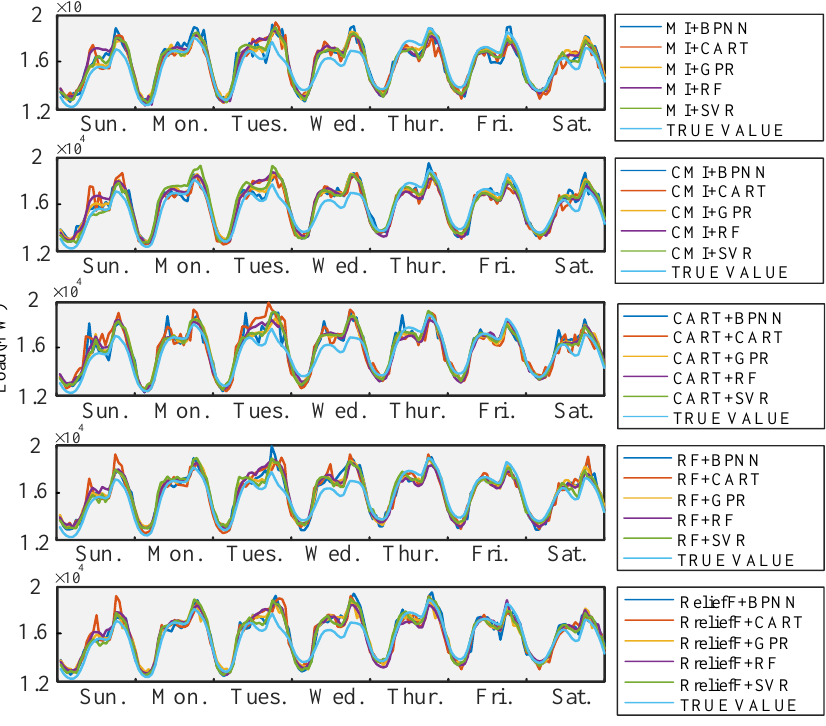
Figure 6. Prediction from 22 to 28 December 2013. Table 7. Comparison of different combined methods.